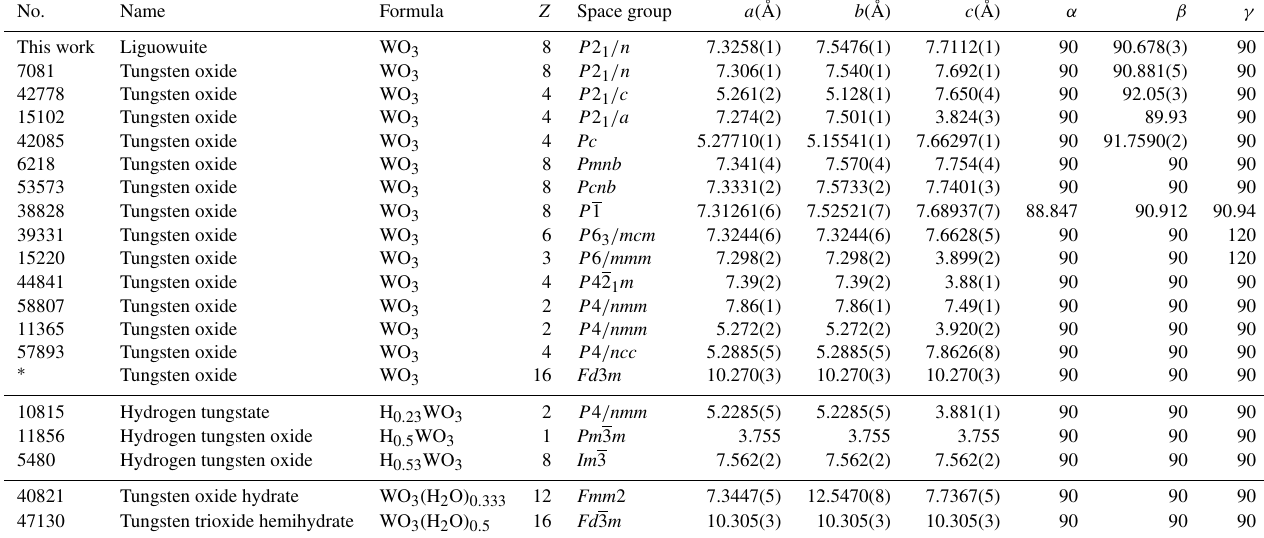
Table 6. Data for comparison of liguowuite with related synthetic materials.